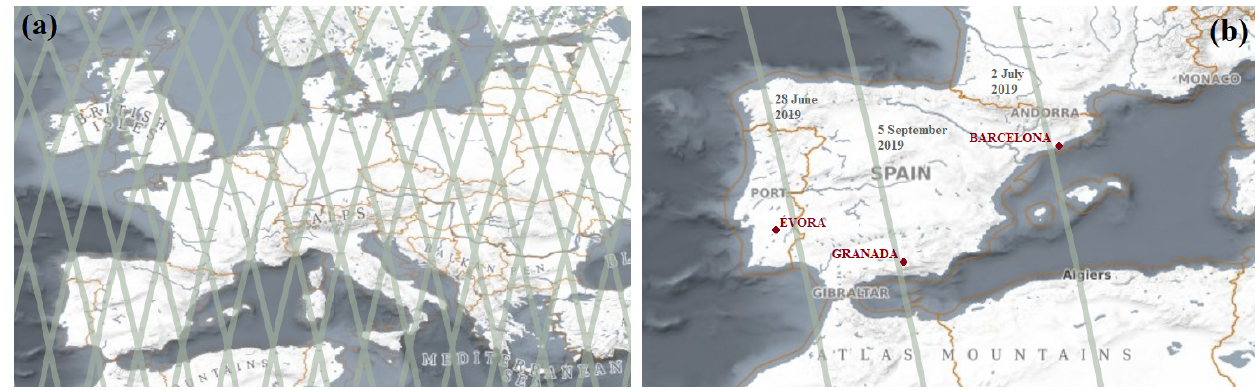
Figure 1. (a) Distribution of the Aeolus overpasses over Europe during the considered period (B10, from July 2019 to December 2019 and from 20 April 2020 to 6 October 2020). (b) Location of the stations in Évora, Granada and Barcelona as well as the associated over- passes during the case studies analyzed in Sect. 4.2. (Source: ESA Aeolus online dissemination, https://aeolus-ds.eo.esa.int, last access: 7 January